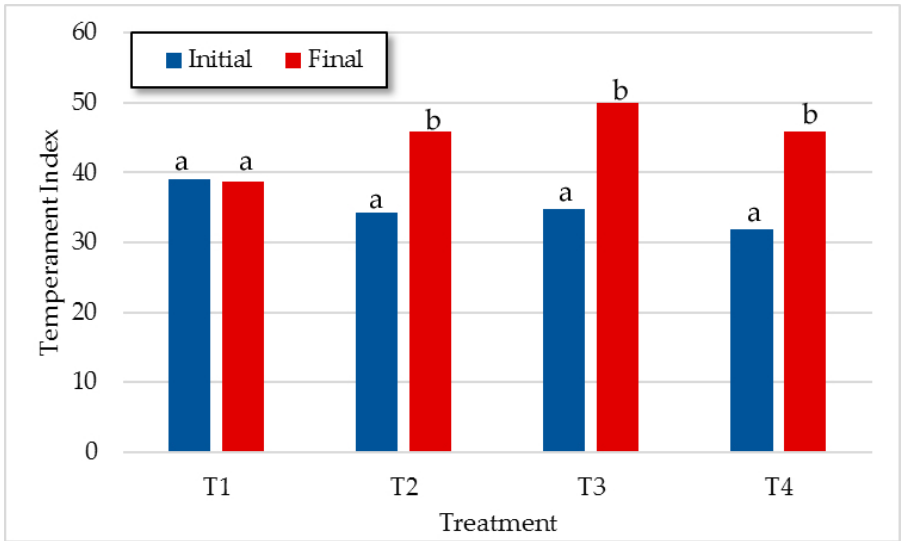
Figure 2. Least square means for initial and final TIndex within treatments. a,b Means within the same treatment with different letters differ with p < 0.05.